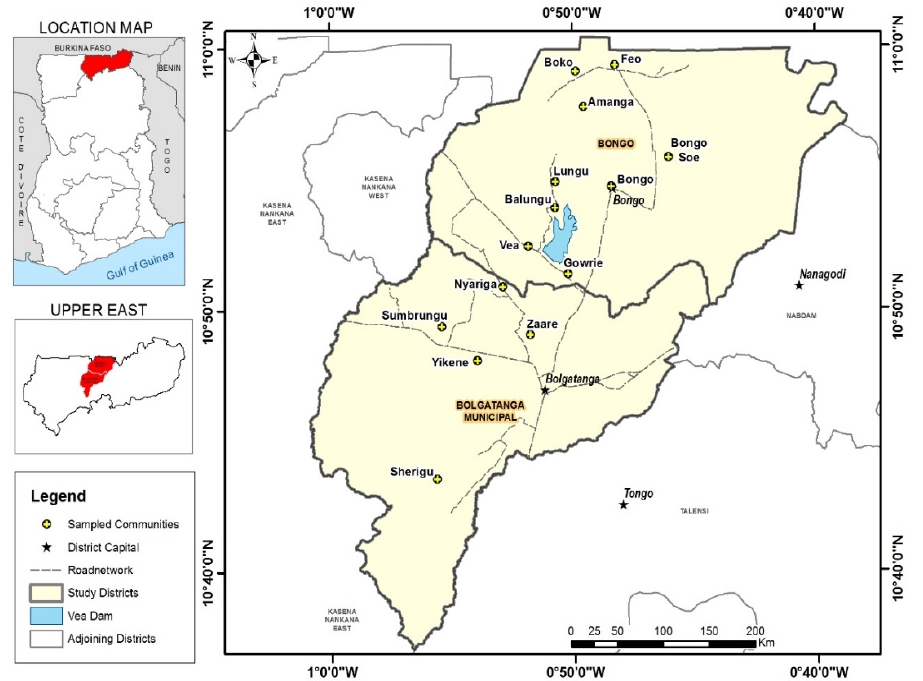
Figure 1. Map of the study area.